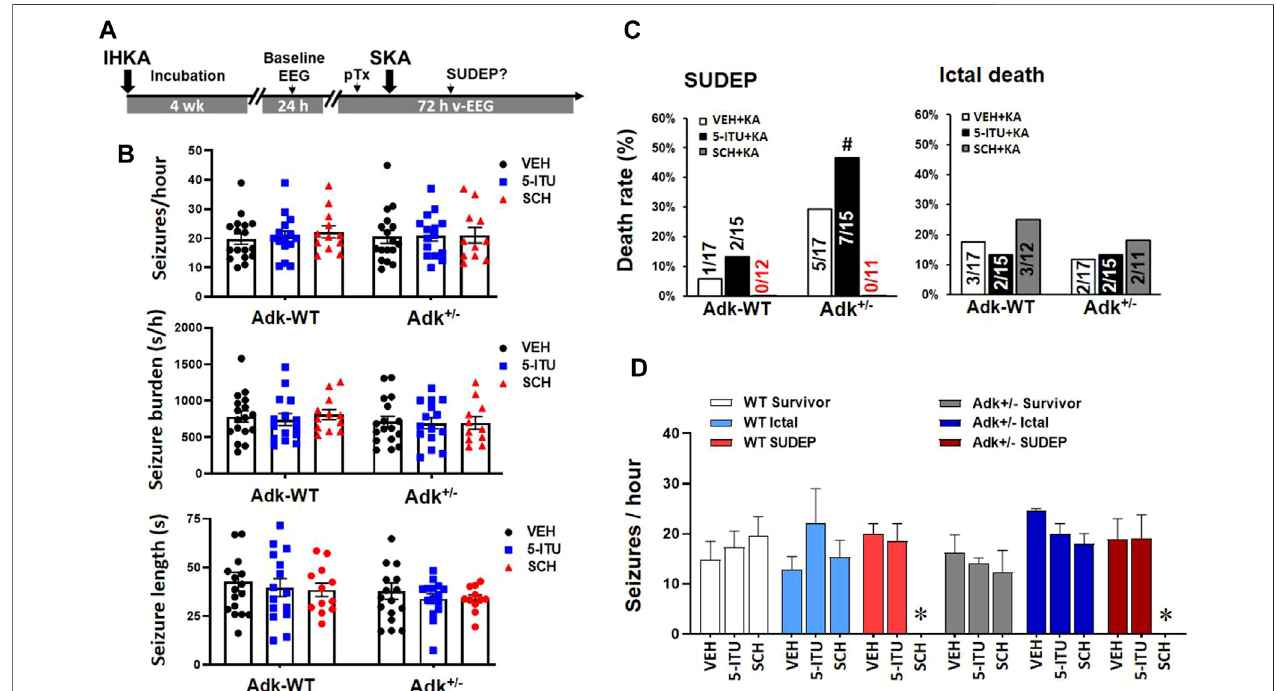
FIGURE4| A 2A RantagonistSCH58261reducedSUDEPoccurrenceinepilepticmice. (A) Theparadigmofpharmacologicalpretreatment(pTx)intheboostedKA model of SUDEP. (B) EEG validation of epileptic phenotypes in each group of Adk +/- mice and their littermates (Adk-WT) at 4 weeks after IHKA injection, prior to the experimental SKA (15 mg/kg, i. p.) injections. (C) Rates of ictal death, SUDEP, and total mortality among groups with pretreatment of i. p. injection of vehicle (VEH), 5- Iodotubercidin (5-ITU, 2 mg/kg), and SCH58261 (SCH, 3 mg/kg). (D) Baseline EEG evaluation of seizure onset frequencies (seizure/hour) in mice grouped as survivors, ictal death, and SUDEP, with different pretreatments of a VEH, 5-ITU, or SCH. * Indicating zero animals with SUDEP existing in the marked (SCH) group. # p < 0.05 vs. same treatment group in Adk-WT mice, Chi-square test.